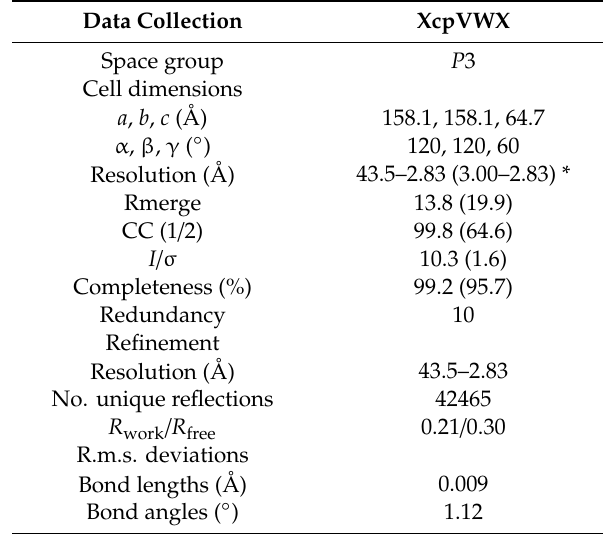
Table 1. Data collection and refinement statistics.